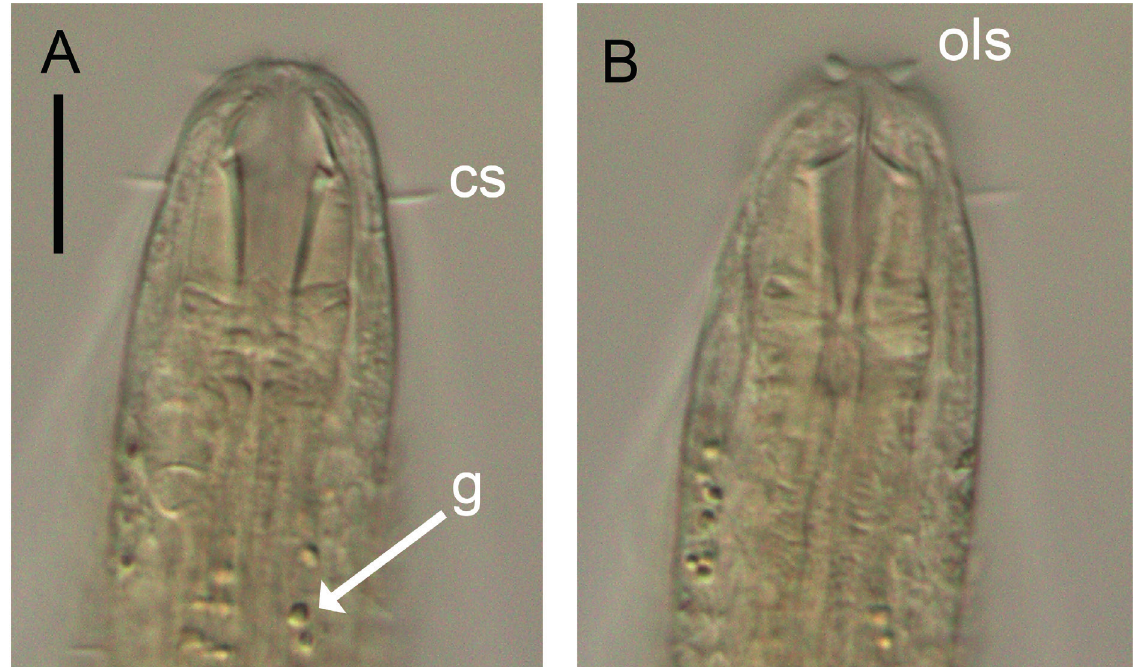
Fig. 8. Halanonchus scintillatulus Leduc sp. nov., light micrographs, ♀, paratype (NNCNZ3329). A . Sublateral optical cross section of buccal cavity showing teeth-like structures at anterior edge of stegostoma wall. B . Subsurface view of same specimen showing discontinuity in cuticularisation of buccal cavity wall between gymnostoma and stegostoma, and at the junctions between the dorsal and ventrosublateral sectors, which may be interpreted as forming “oval structures”. Abbreviations see Material and methods. Scale bar = 10